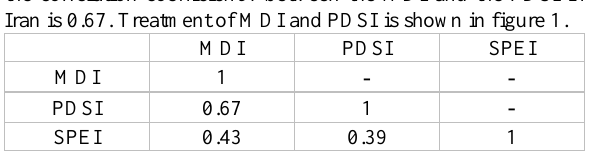
Table 3: Correlation matrix of drought indices computed for the